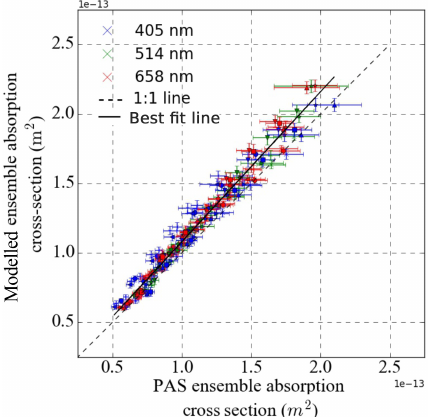
Figure 7. Modelled versus PAS-measured absorption cross sections for nigrosin aerosol at 405, 514 and 658nm